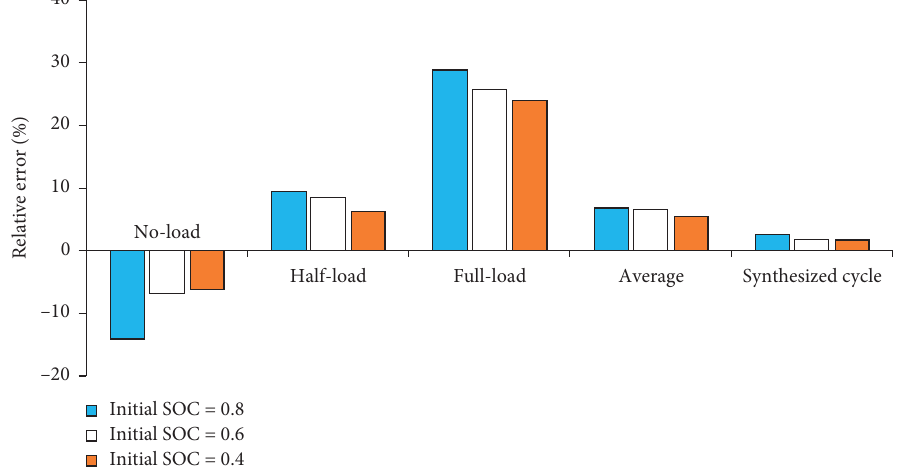
Figure 29: Relative error of the FC for different loads versus the mean